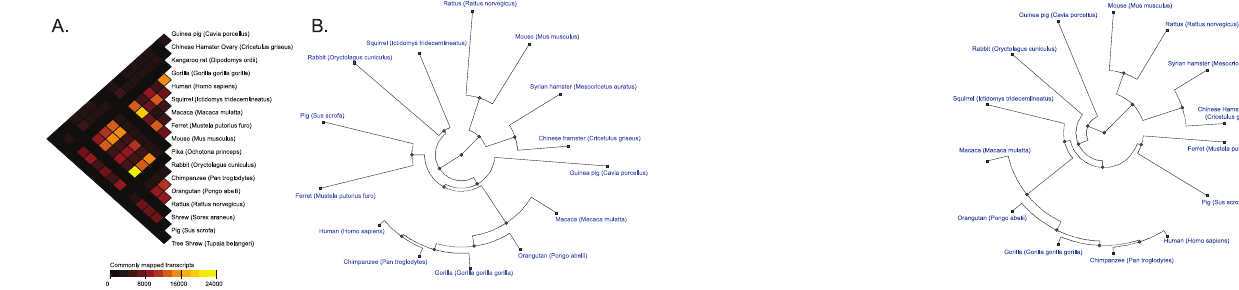
Figure 4. Distogram showing the commonly mapped transcripts and phylogenetic tree showing the divergences amongst the different species. (A) Distogram showing the number of transcripts commonly mapped by the Syrian hamster transcriptome between the different species used in this study. Each cell of the distogram represents the number of transcripts commonly mapped by two different species using a gradient color. (B) Phylogenetic tree showing the genomic divergence between a subset of the different species used in this study. Each leaf of the tree represents a different species and the distances of the edges are proportional to the genomic distances between the species. Genomic distances have been calculated based on the list of 611 Syrian hamster contigs and singletons that have been commonly aligned on the transcriptome references of the 13 species having the highest number of commonly aligned sequences. doi:10.1371/journal.pone.0112617.g004 PLOS ONE |